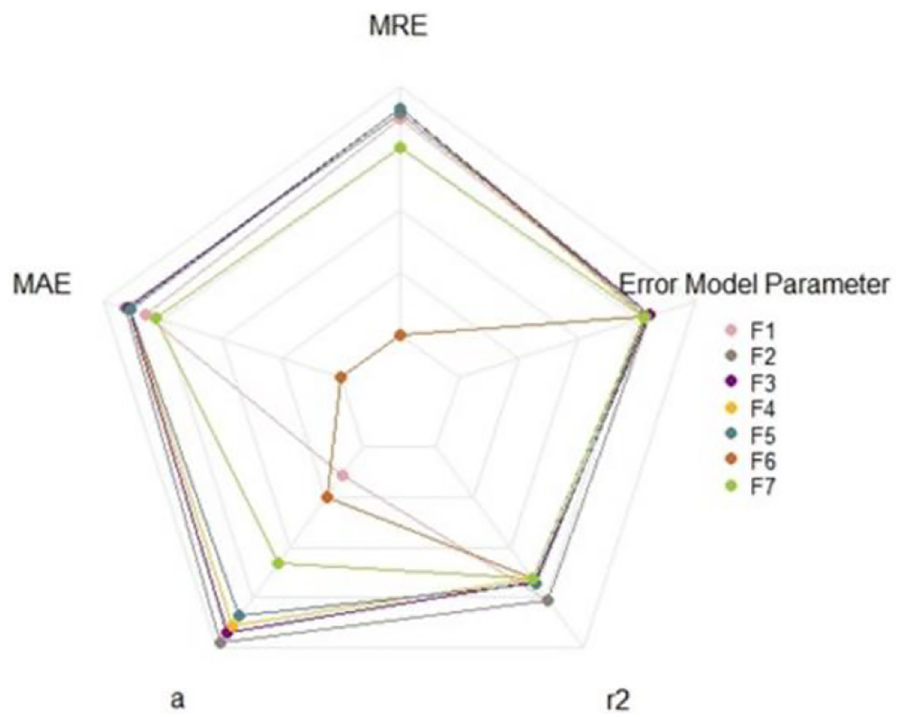
Fig 5. Radar chart displaying volume estimation data for Formula 1 (F1), Formula 2 (F2) Formula 3 (F3), Formula 4 (F4), Formula 5 (F5), Formula 6 (F6) and Formula 7 (F7). The larger the area, the better the prediction. All raw data used to make this chart are available in supplementary tables (S4 Table). � MRE = mean relative error, MAE = mean absolute error, r 2 = correlation coefficient of regression line, a = slope of regression line.